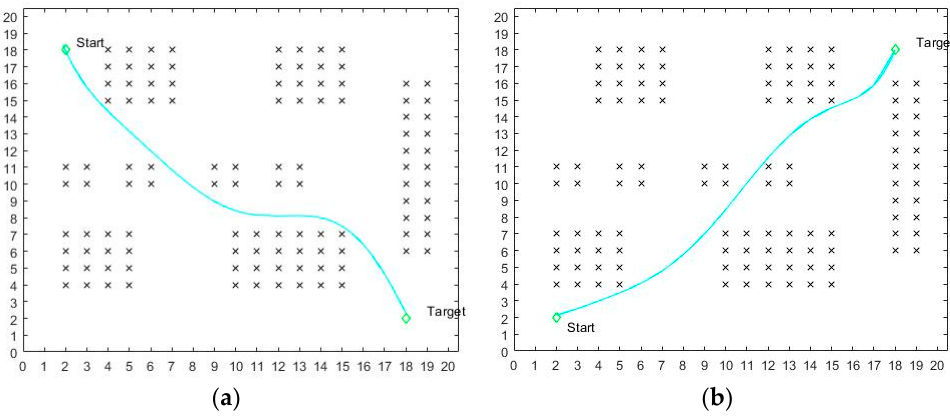
Figure 12. Path fitting results. (a) Figure 11(a) path fit; (b) Figure 11(b) path fit.